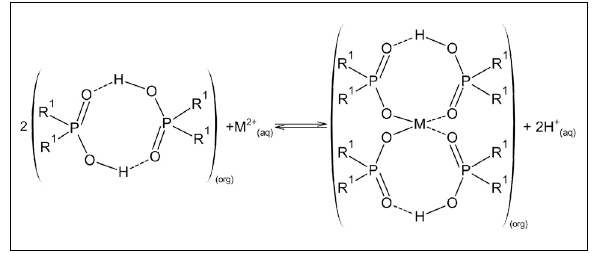
Source: Adapted from Wilson et al. 33 under CC-BY licence Figure 3: Extraction mechanism of Cyanex 272 (R 1 = C